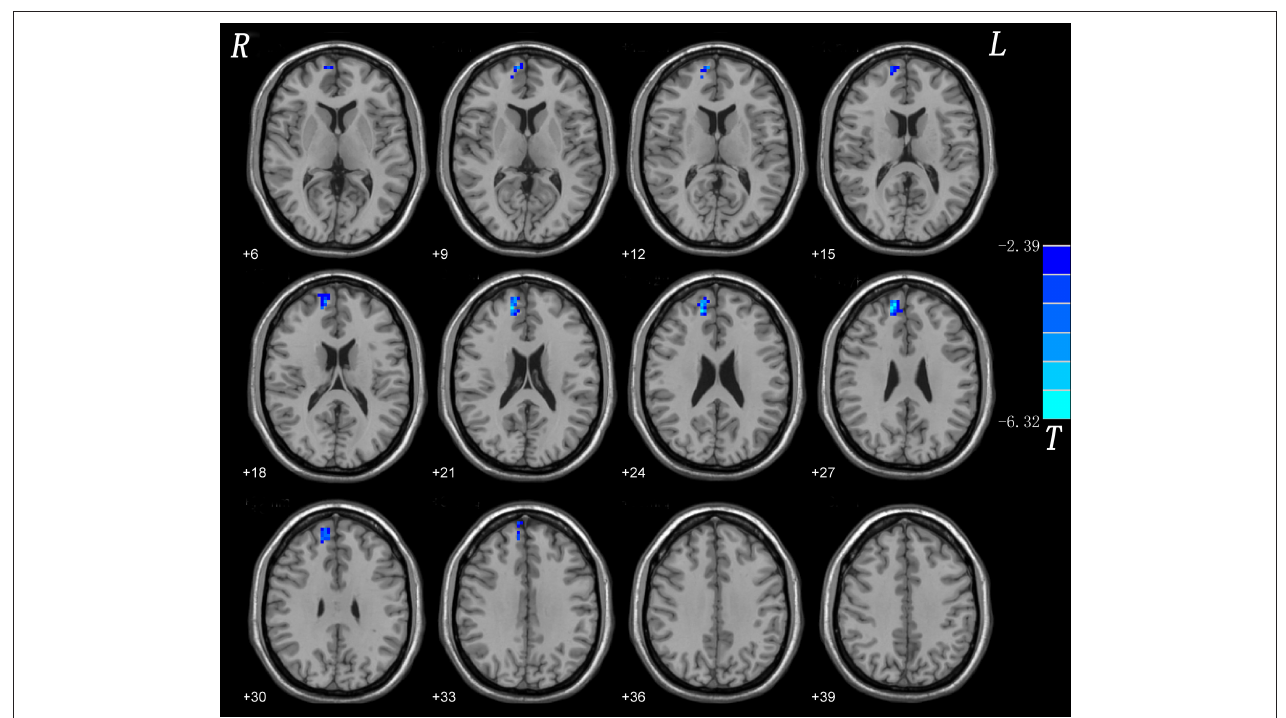
FIGURE 2 | Split-half validation. Comparisons of whole-brain NH were performed between 10CD patients and 11 healthy controls. Blue denote lower NH respectively and the color bars represent the t value from two-sample t -test of the group analysis. NH, network homogeneity; CD, cervical dystonia.